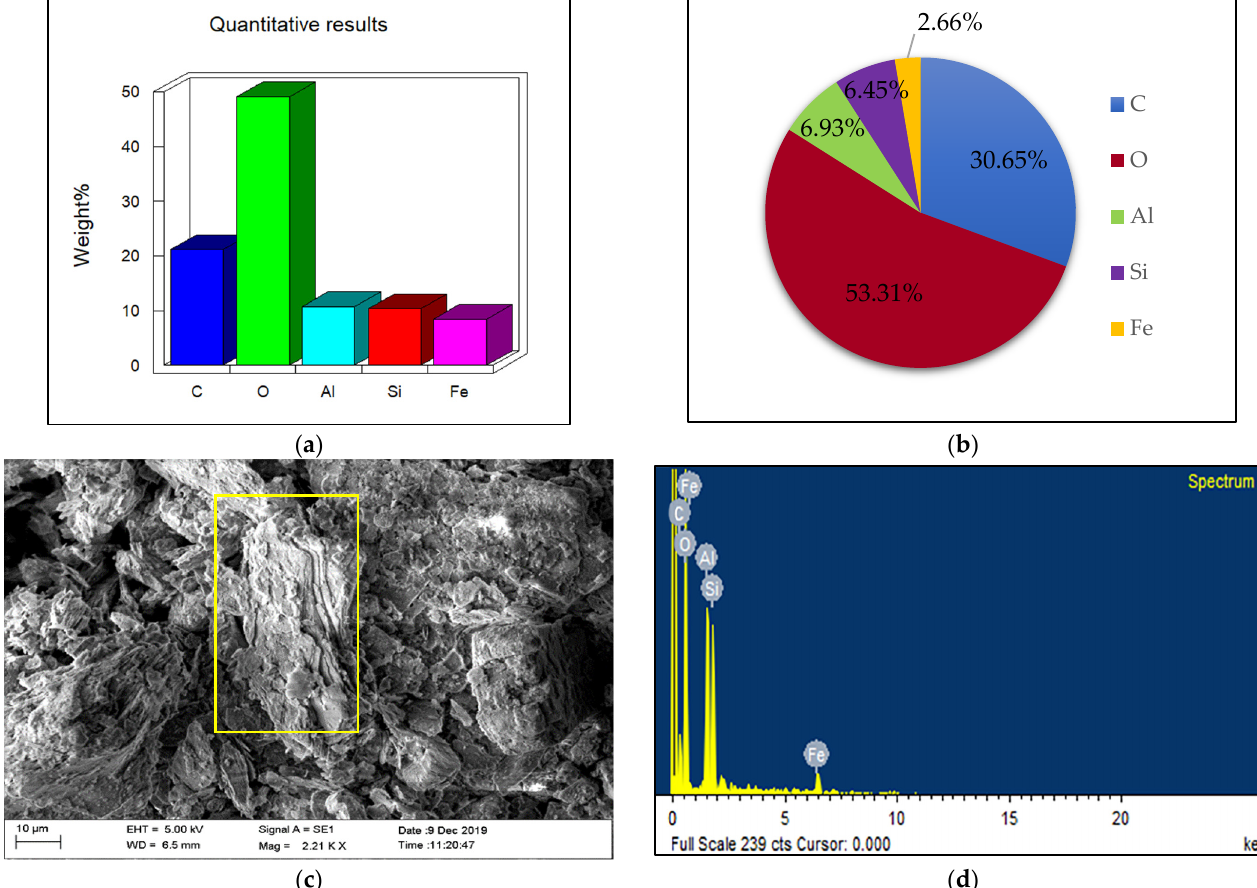
Figure 17. EDS analysis of Valandhur sample; ( a ) elements weight (%), ( b ) atomic weight (%), ( c ) SEM image, ( d ) spectrum image.